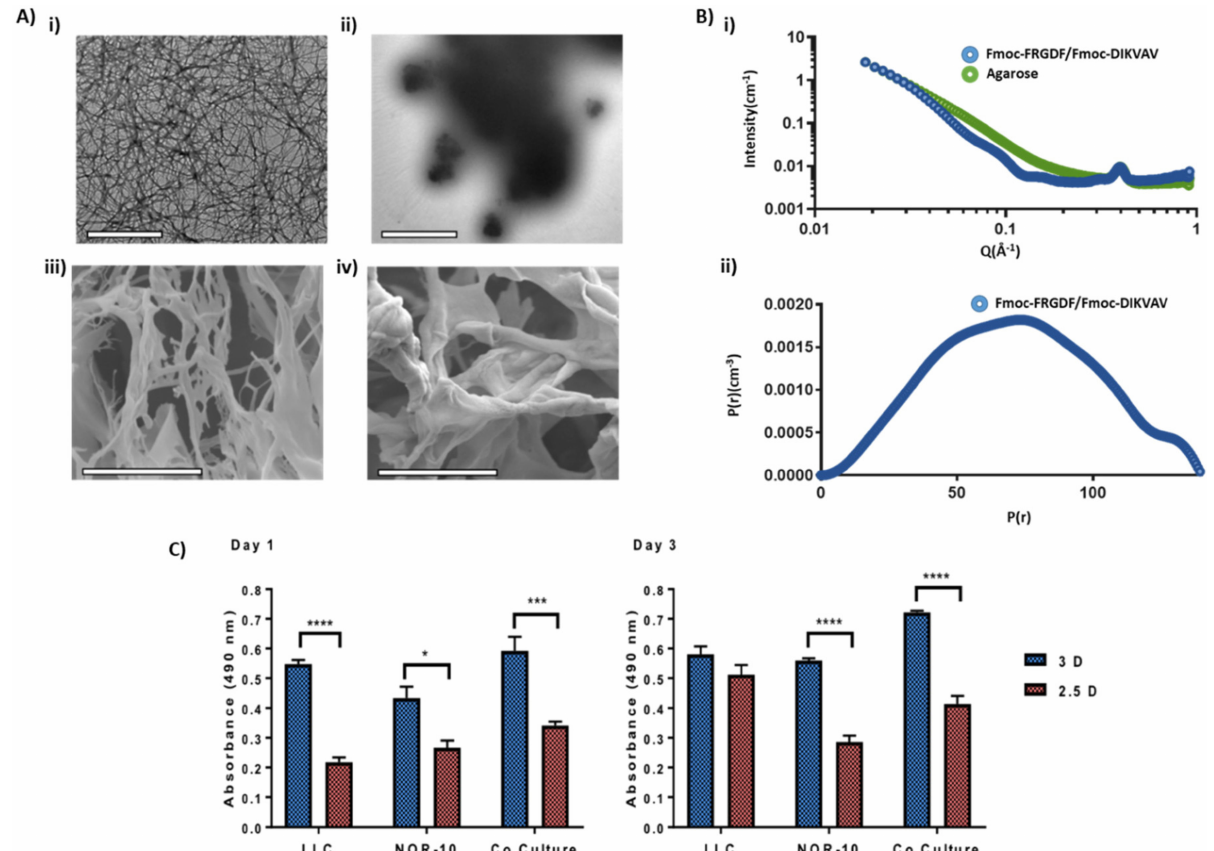
Figure 2. Material characterisation and assessment of cellular metabolic activity. ( A ) TEM and CryoSEM analysis of 1% agarose and Fmoc-SAP co-assembled hydrogels. Top: TEM analysis of (i) Fmoc-FRGDF/Fmoc-DIKVAV co- assembled hydrogel and (ii) Agarose hydrogel (scale = 1 µ m). Bottom: CryoSEM analysis of (iii) 1% agarose and (iv) Fmoc-SAP co-assembled hydrogels imaged at 3000 × magnification (scale = 20 µ m). ( B ) Fitting of scattering curves obtained during SAXS investigation. (i) Fitting for correlation length, and (ii) fitting to two-power model used for the determination of mesh size (arrows indicate the power intercept). ( C ) A comparison of the metabolic activity of LLC, NOR-10 and co-culture 3D and 2.5D spheroids, measured by MTS assay at 490 nm wavelength after an incubation time of 1 and 3 days. Data is presented as mean ± SEM, n = 3. Statistics were obtained by two-way ANOVA with the Tukey’s multiple comparisons test. * p < 0.05, *** p < 0.001, **** p < 0.0001. 24 h after seeding, metabolic activity was significantly higher for all